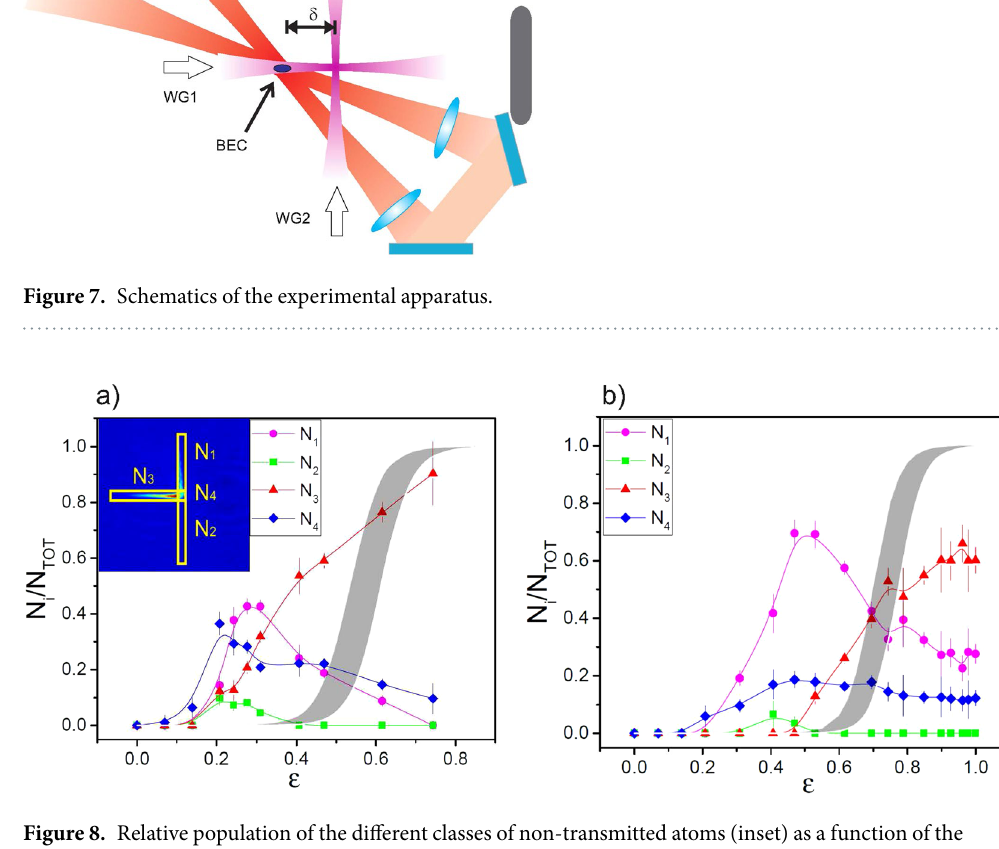
order gaps, which open closer to the crossing center at a distance ~ w 0 , as derived from the solution of the Mathieu equation. Even if this results in a higher probability of reflection into WG2, at this distance however the atoms cannot yet directly enter WG2 once reflected by the band gaps, see Fig. 2b. Motivated by the good agreement between the experimental measurements and the results of the numerical simulations shown in Fig. 3, we can rely on the latter for understanding the mechanism responsible for guiding the atoms into WG2 after reflection by the spatial gaps. We observe a progressive change from a situation where these dynamics are mainly driven by the boundaries of the waveguides’ trapping potential at low velocities, to a cascade of multiple reflections by several spatial gaps opening in the xy -plane for increasing atomic velocities. Additionally, the fraction of atoms reflected into WG2 (in a single port) is always below 50%, see Figs 3 and 4a. Indeed, for increasing lattice depths the atoms are blocked at the edge of the crossing region in WG1 as shown in Fig. 4c, see also Methods for a more detailed analysis of the atom number in the different exit ports and in the crossing region. Note that quantum reflection by a single lattice site, estimated analytically by using a similar barrier shape 17 , occurs only for relatively high lattice amplitudes in this range of velocities, see Methods. Neither the observed reflection into WG2 or the blocking of the atoms at the edge of the crossing region can be explained with reflection by a single barrier. They are thus due to the periodic potential and, more specifically, to the action of spatial gaps of different order. Finally, when increasing the velocity above v 2 an increasingly larger fraction of the atoms are reflected into WG2, to the point where an almost complete reflection can be achieved (85% of the atoms in the trap for the maximum velocity reported in Fig. 3). The higher order band gaps are now responsible for the reflection of the atoms at a distance smaller than w 0 from the center of the crossing. In this regime, atoms can exit WG1 to enter